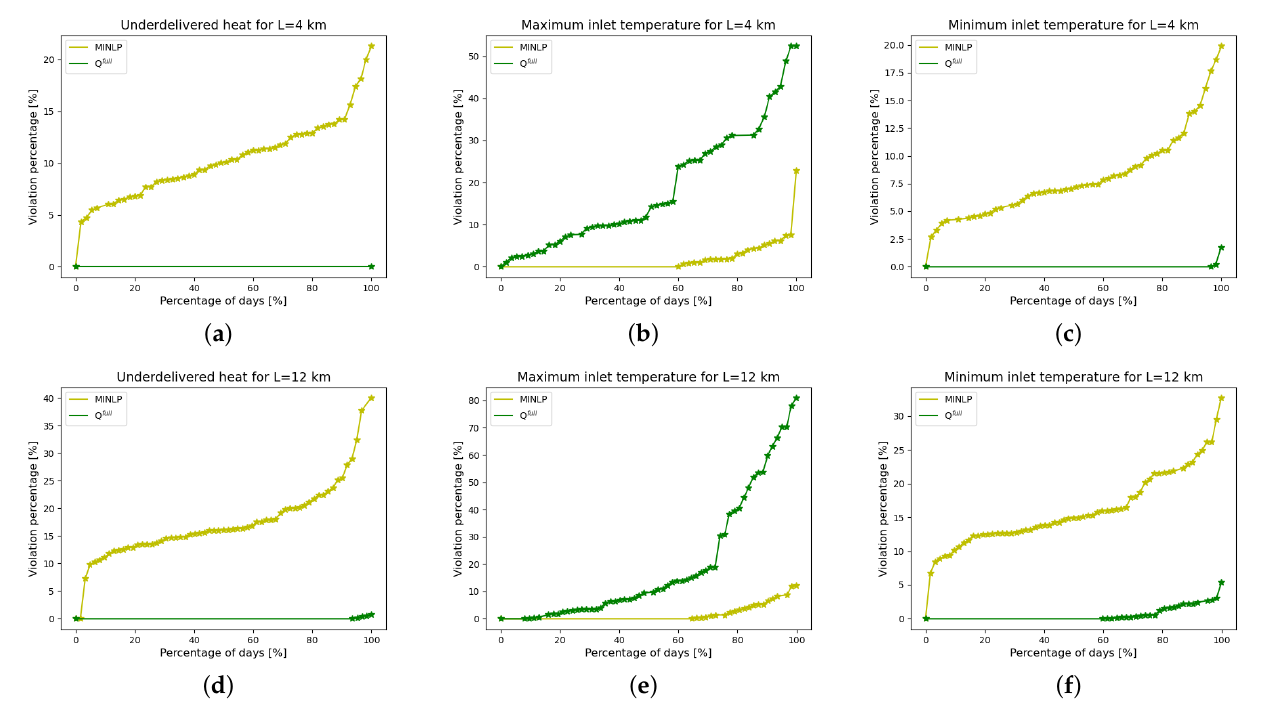
Figure 7. ( a ) Underdelivered heat violation for L “ 4 km. ( b ) Maximum inlet supply temperature violation for L “ 4 km. ( c ) Minimum inlet supply temperature violation for L “ 4 km. ( d ) Underde- livered heat violation for L “ 12 km. ( e ) Maximum inlet supply temperature violation for L “ 12 km. ( f ) Minimum inlet supply temperature violation for L “ 12